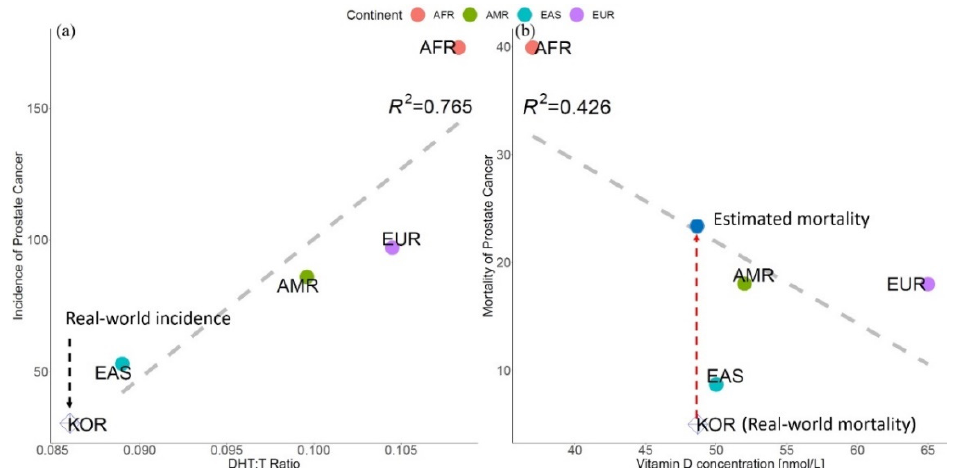
Figure 4. ( a ) Correlation plot of dihydrotestosterone (DHT) to testosterone (T) ratio and prostate cancer (PCa) incidence. Linear regression is indicated by the gray dashed line ( R 2 = 0.765), and the real-world Korean incidence is represented by the blue open rhombus. ( b ) Correlation plot of vitamin D concentration and prostate cancer (PCa) mortality. Linear regression is in the gray dashed line ( R 2 = 0.426), and the real-world Korean PCa mortality is represented by the blue open rhombus, which deviates from the linear regression, whereas the estimated Korean mortality is in the blue shaded circle. (AMR: American, EUR: European, AFR: African, EAS: East Asian, KOR: Korean).